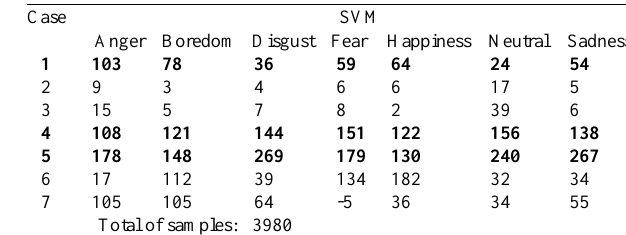
Table 3: Performance of proposed system for offline samples.